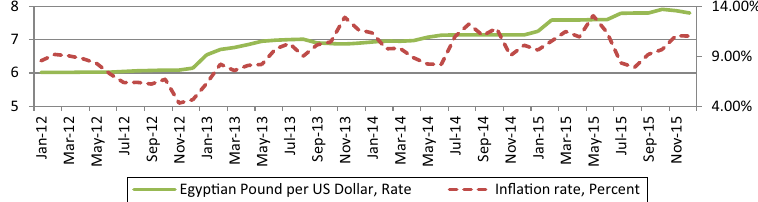
Figure 2. In fl ation rate and exchange rate